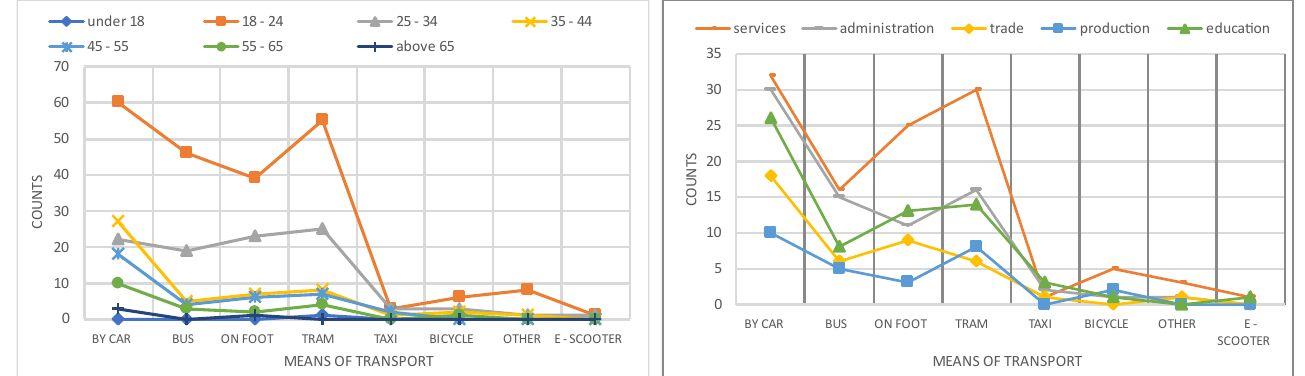
Figure 4. The choice of individual means of transport in the home – work direction.